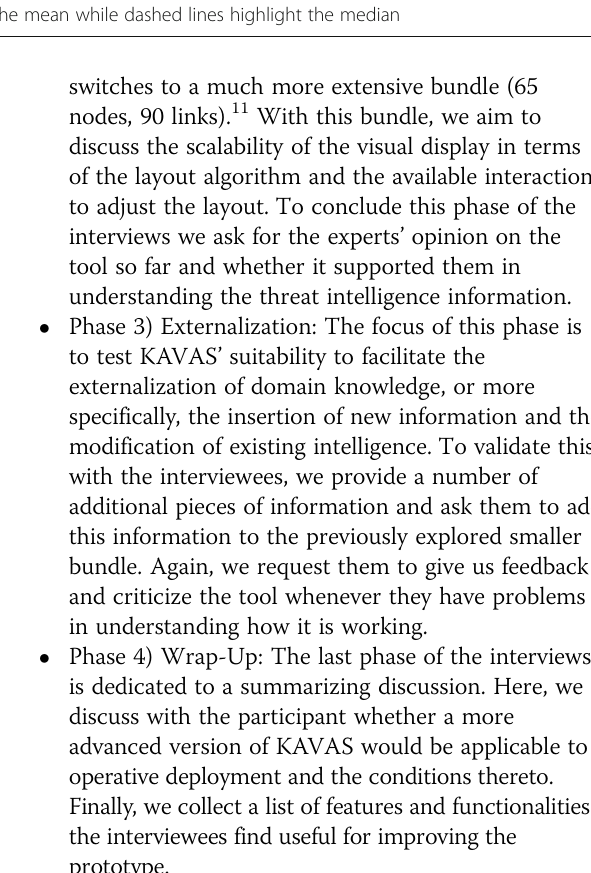
Table 1 KAVAS survey